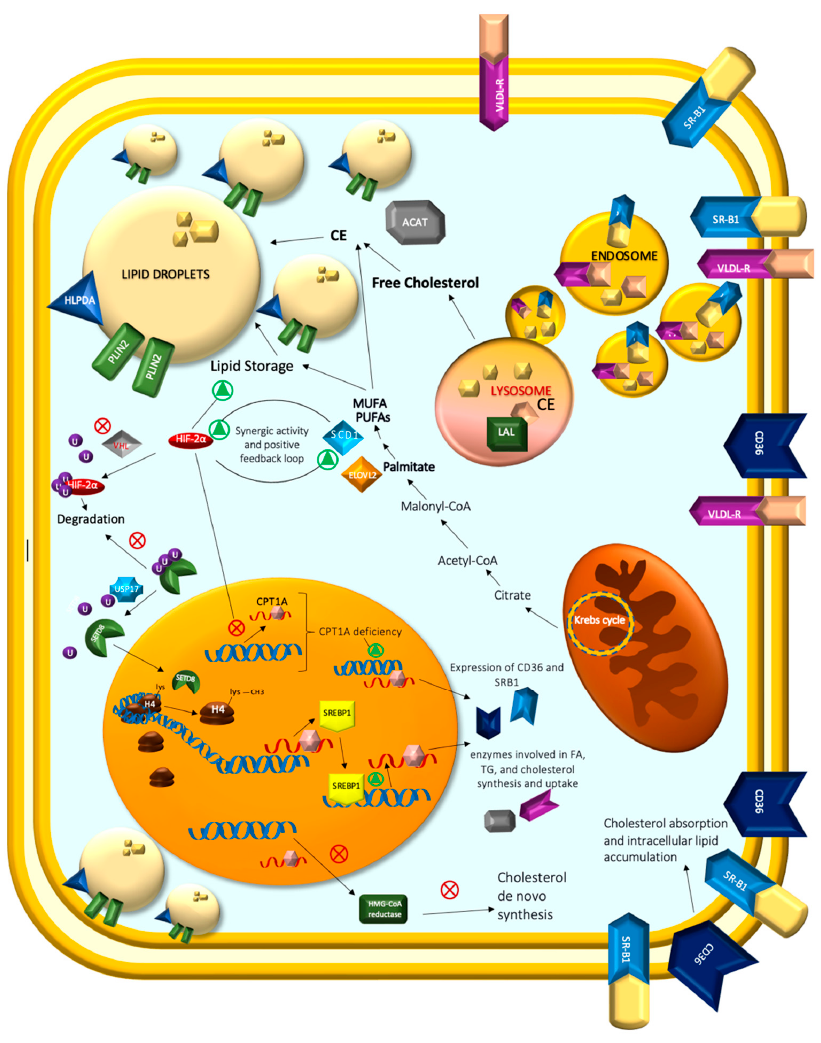
Figure 3. A hallmark of ccRCC is the accumulation of cholesterol, cholesterol esters, and other lipids collected in intracellular lipid droplets (LDs). LD-associated proteins, PLIN2 and HILPDA, are over- expressed in ccRCC, regulate lipid storage, and enrich lipids that contain polyunsaturated fatty-acyl side chains. Cholesterol arrives in RCC cells through direct uptake from the diet and can be acquired through receptors: very low-density lipoprotein receptor (VLDL-R) and scavenger receptor B1 (SR- B1). Once lipoprotein binds to its receptor, it forms an endosome within the membrane, which trans- locates into cells. Following internalization and transport into the lysosome, the cholesterol ester is hydrolyzed by lysosomal acid lipase (LAL) and upregulated in ccRCC to release the free cholesterol. To protect cells from the toxic effects of high free-cholesterol levels resulting from LAL hydrolysis, ACAT re-esterifies free cholesterol with FAs for storage inside the cell. High levels of CE in RCC tumors result from increased activity of this enzyme. Cholesterol de novo synthesis in ccRCC is reduced because of decreased levels of HMG-CoA reductase. Therefore, cholesterol accumulation in ccRCC is likely the result of increased uptake rather than excessive biosynthesis from acetate. SREBPs are transcription factors that regulate enzymes involved in cholesterol and fatty acid bio- synthesis. Once inside the nucleus, they bind to the promoter regions of SREBP target genes and initiate the expression of enzymes involved in FA, TG, and cholesterol synthesis and uptake. SETD8 is stabilized by deubiquitination mediated by ubiquitin-specific protease 17 (USP17) and modulates the transcription of SREBP1 as a direct target by methylating the 20th lysine of histone-4 with enor- mous effects on lipogenesis. The long-chain fatty acid transferase CPT1A is decreased in ccRCC